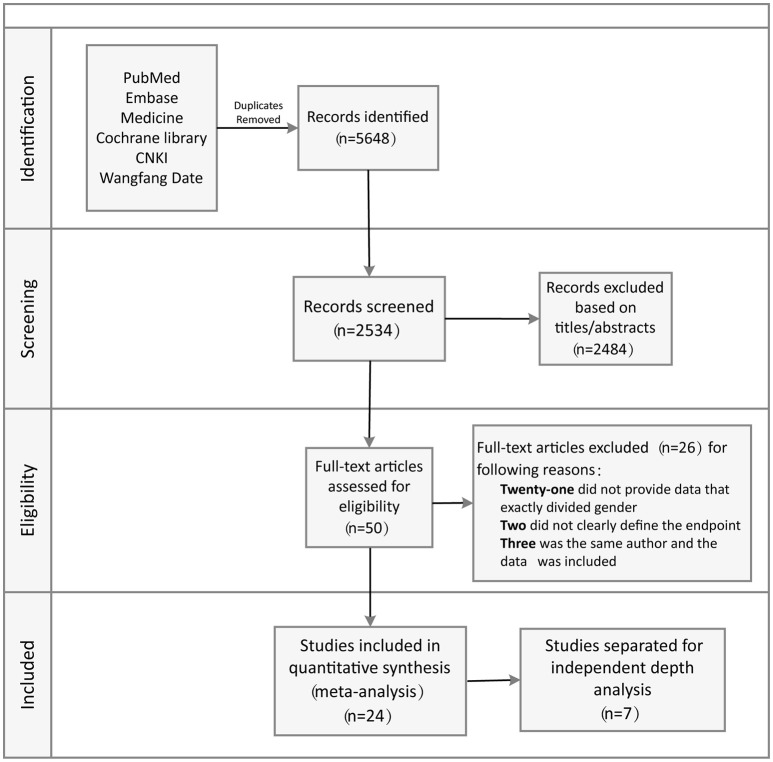
Flow diagram of data search and study selection.